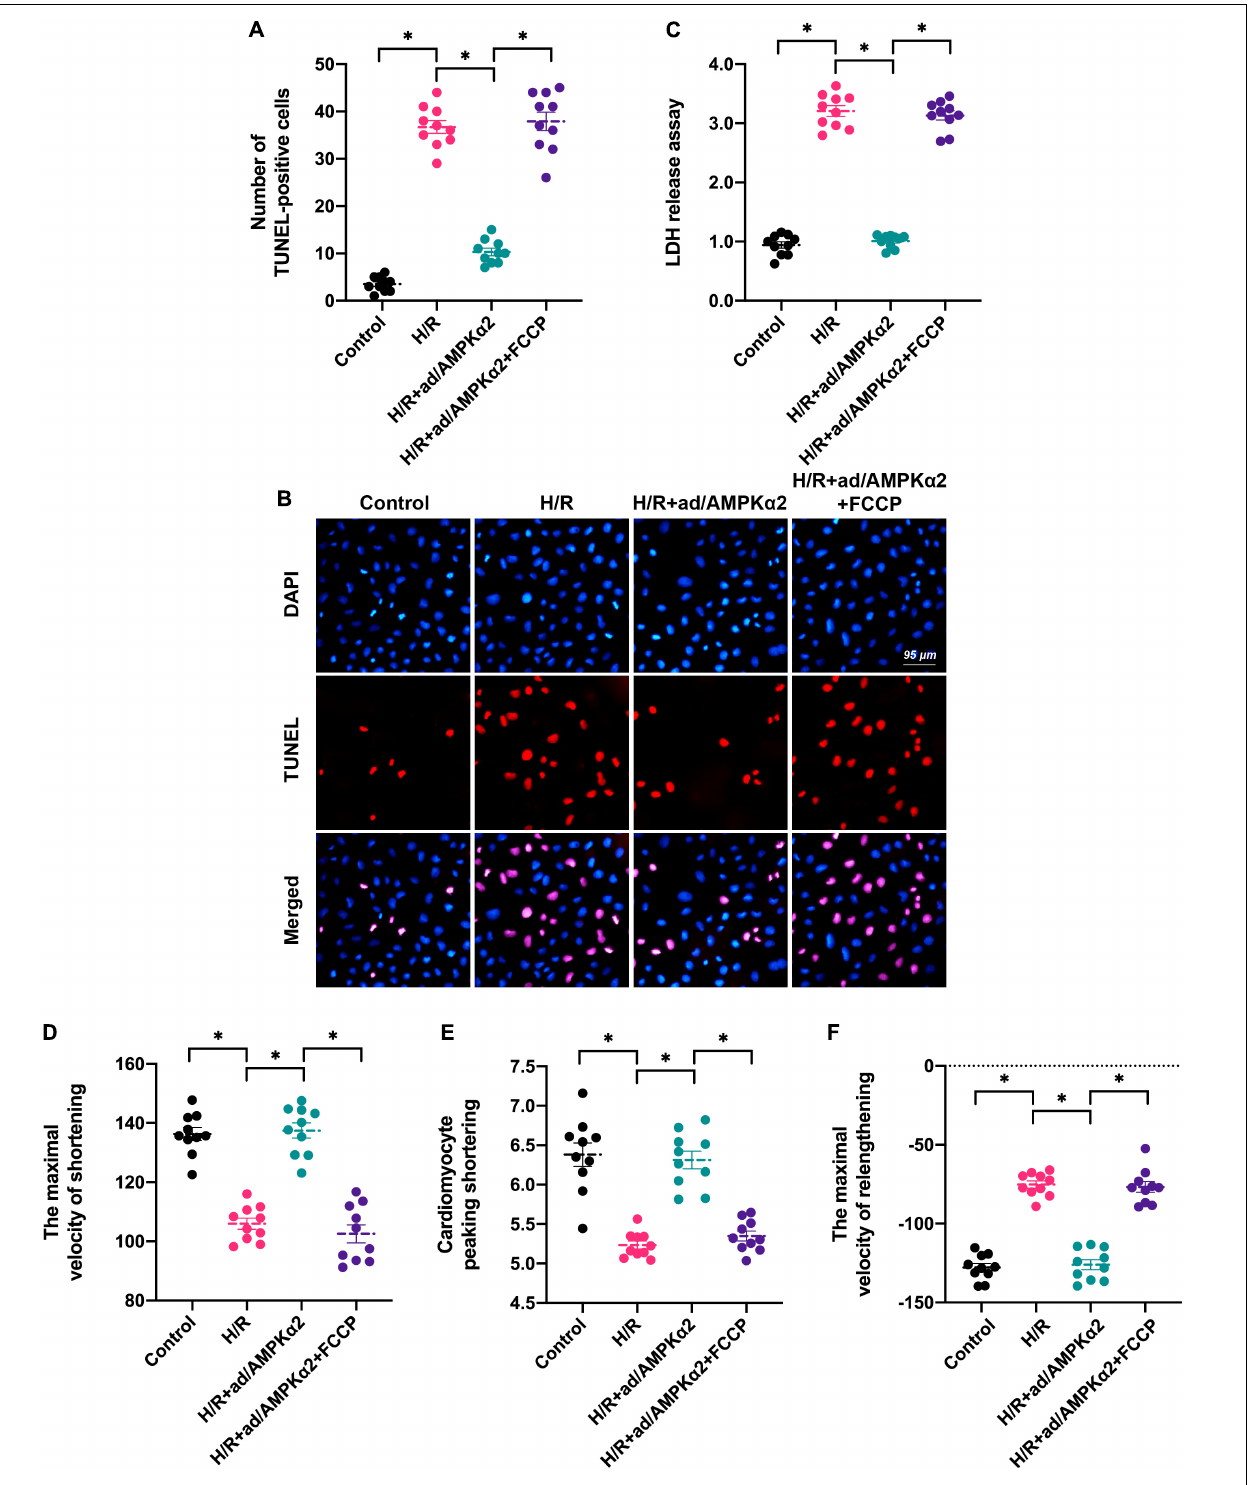
FIGURE 4 | Induction of mitochondrial dynamics disorder abolishes AMPK2 α overexpression-mediated cardioprotection. (A,B) TUNEL staining was applied to observe cell apoptosis. Cardiomyocytes transfected with AMPK α 2 adenovirus were treated with FCCP to induce mitochondrial dynamics disorder. Then, the number of TUNEL-positive cells was recorded. (C) LDH release assay was used to measure cell viability. (D–F) The cardiomyocytes contractile properties in the context of H/R injury. The data represent the mean ± SEM. P < 0.05.